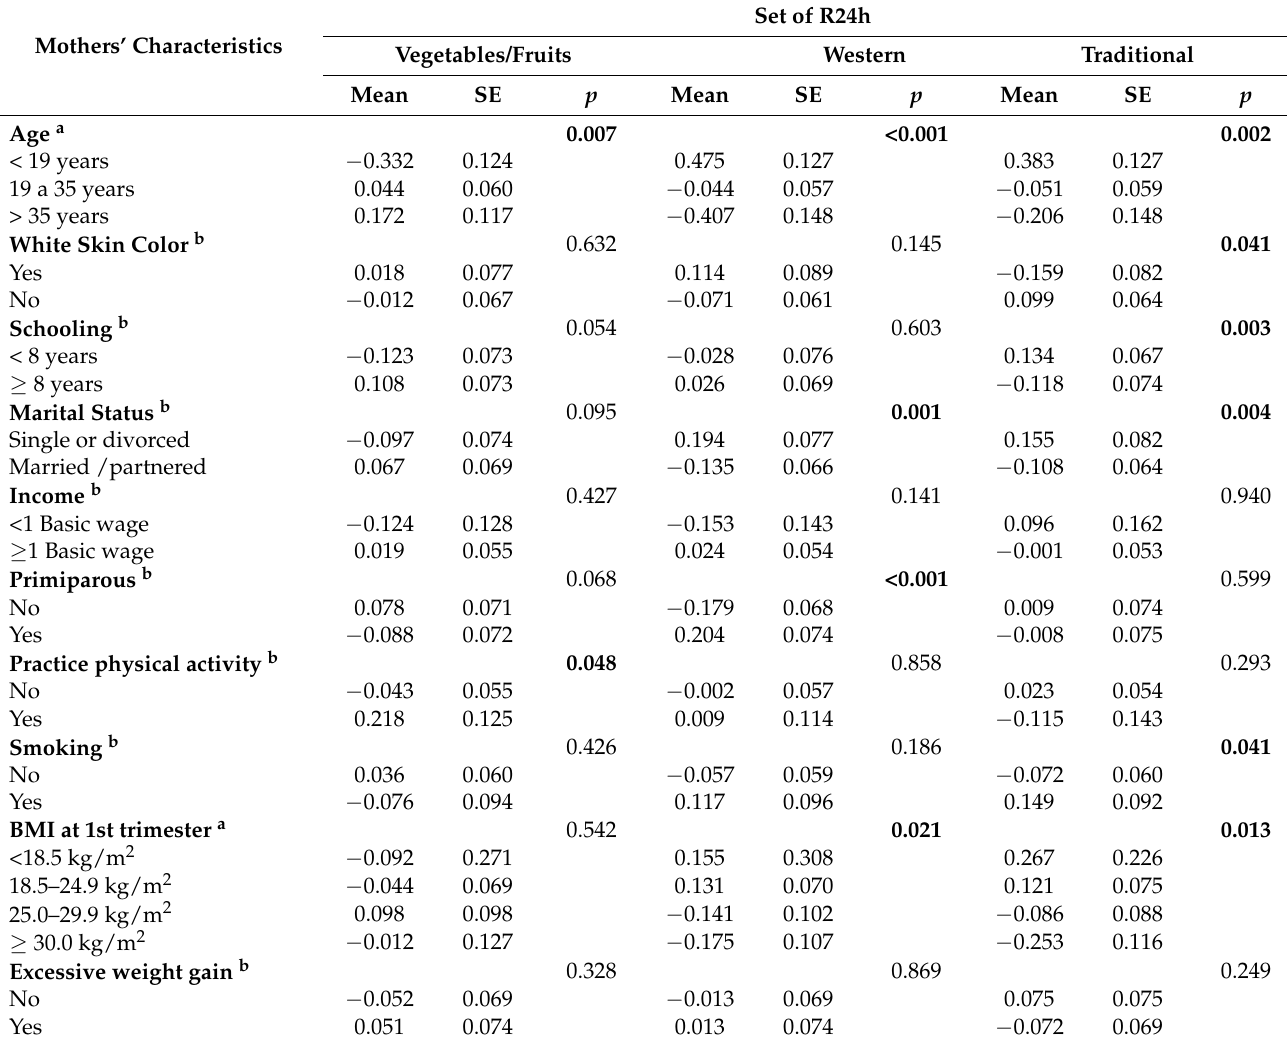
Table 3. Maternal sociodemographic, BMI, and EGWG according to the three dietary patterns identified in the 24HR sets, ProcriAr, S ã o Paulo 2011–2013.